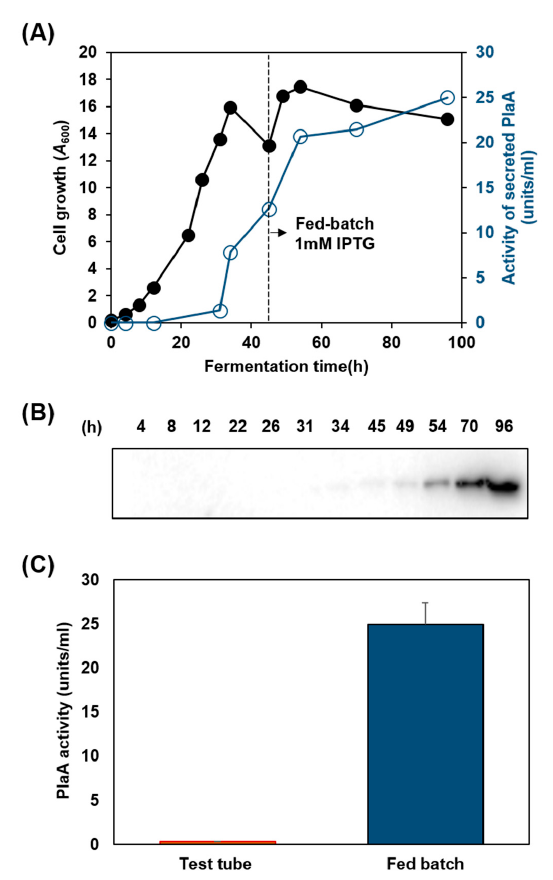
Figure 4. Fed-batch fermentation of P. fluorescens ZYAI harboring ABC / PlaA. The secretory production of PlaA by P. fluorescens ZYAI harboring ABC / PlaA was monitored with the samples collected from the optical density at a wavelength of 600 nm and the activity of secreted PlaA ( ) was measured by (cid:35) pH-stat. ( B ) Western blot analysis was carried out with the culture supernatant using anti-His-tag. ( C ) The PlaA activity of 5 mL M9 medium and fed-batch fermentation in a 5 L fermenter was measured by pH-stat. Error bars represent the standard deviation from three independent